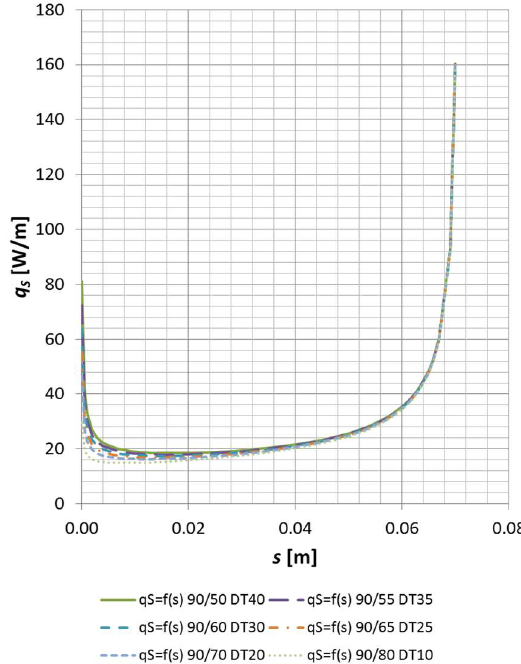
Figure 3. The dependence of the unit heat flux of the supply pipe as a function of the distance between the pipes at different return temperatures ( q S = f(s, T R ) ).